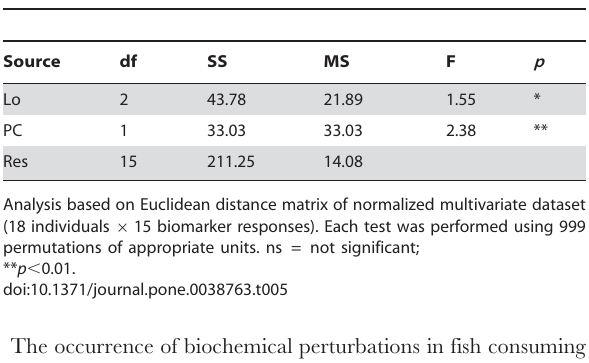
Table 5. PERMANOVA investigating differences among fish populations across locations and between invaded (TG and BR) vs . non-invaded locations (PC).